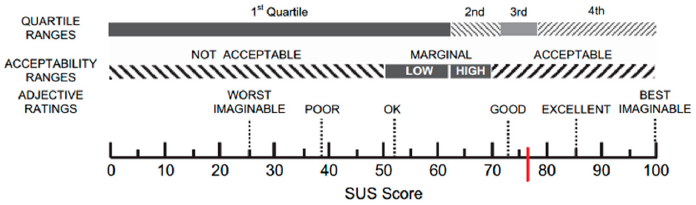
Figure 3. A graphic representation of the SUS’ score.